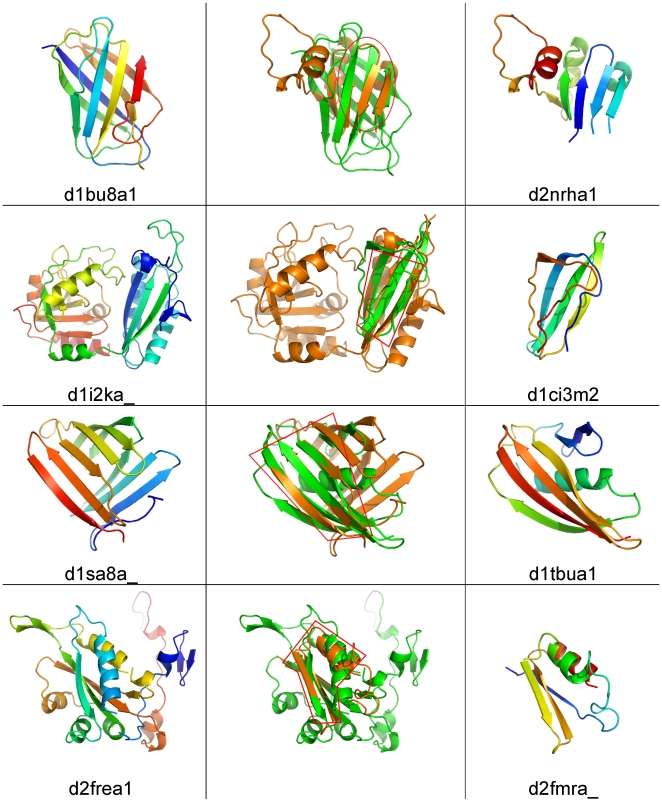
Examples of structural similarities detected in sub-domains of different folds, as classified by the SCOP database.The leftmost column shows the first structure from each pair of partially similar structures, and the rightmost column shows the second structure from each pair. The central column contains structural superposition of each pair. A region of structurally equivalent residues identified by FATCAT is indicated by an red contoured box .